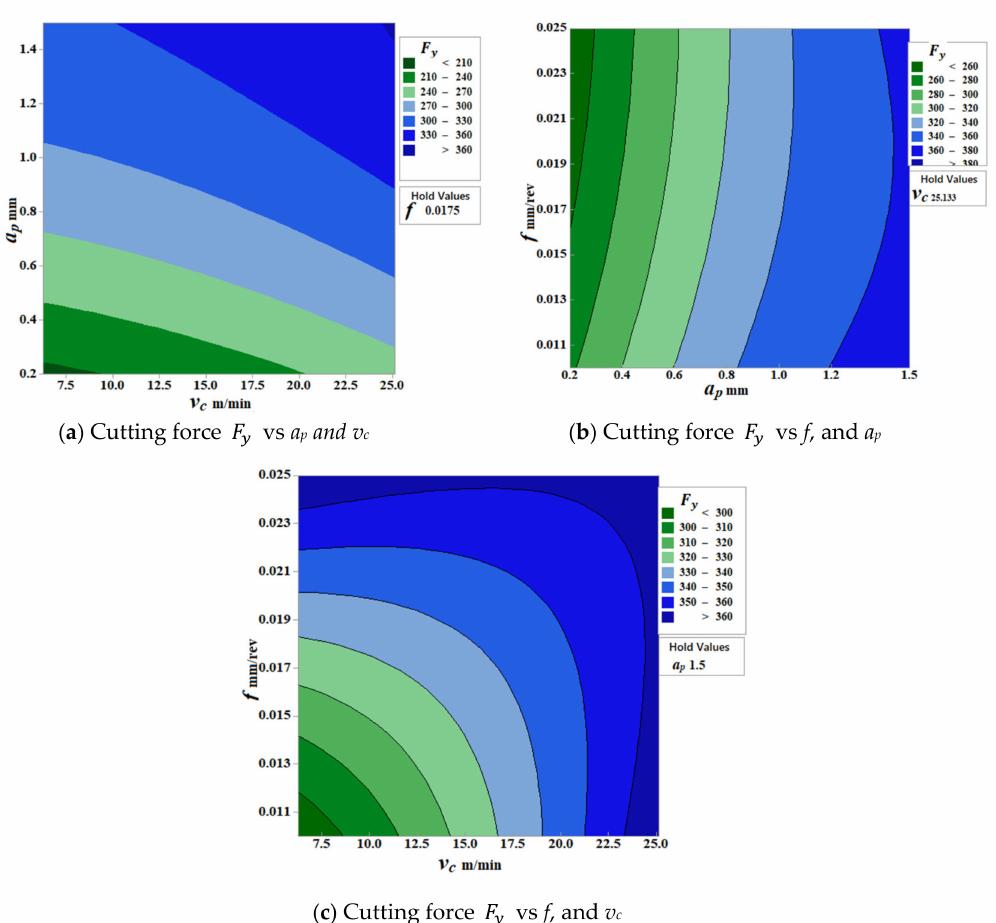
Figure 6. ( a – c ) Cutting force F y vs. v c , f , a p